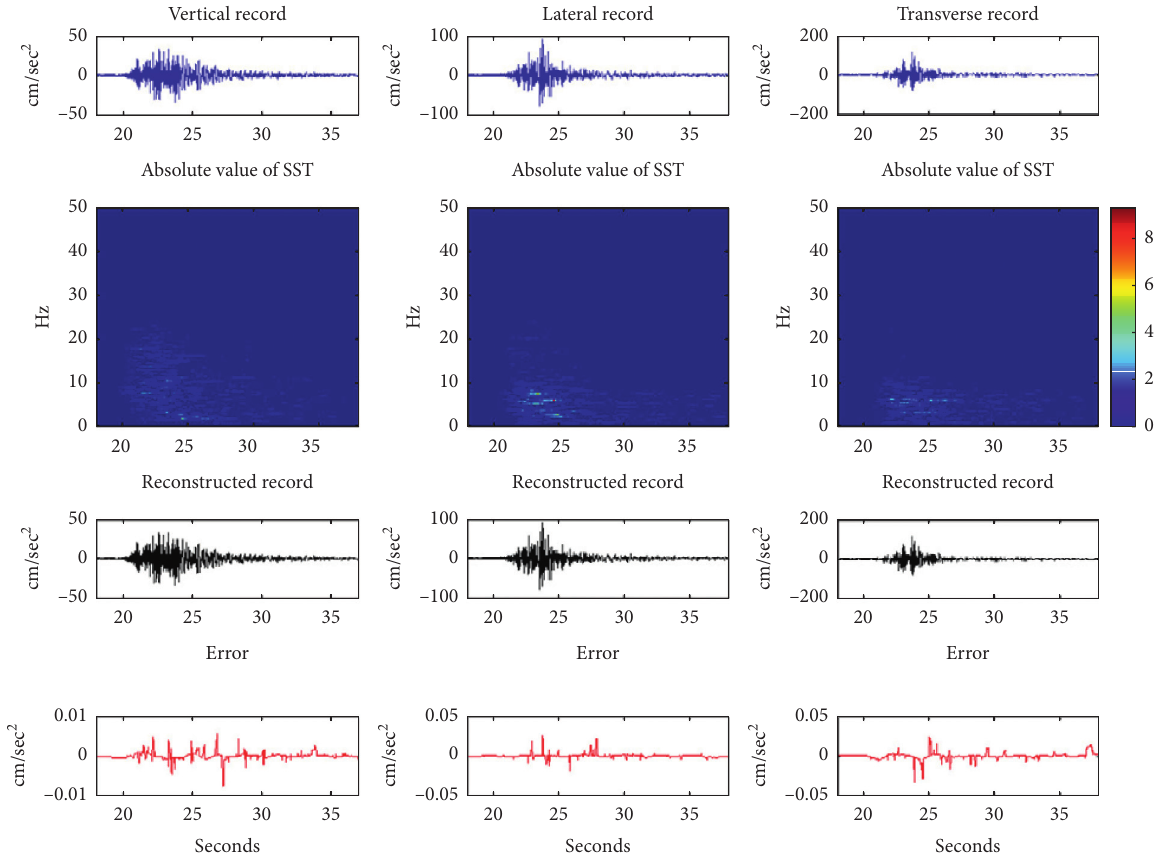
Figure 6: Synchrosqueezing transform analysis of the Mosha earthquake accelerograms recorded in Mosha3